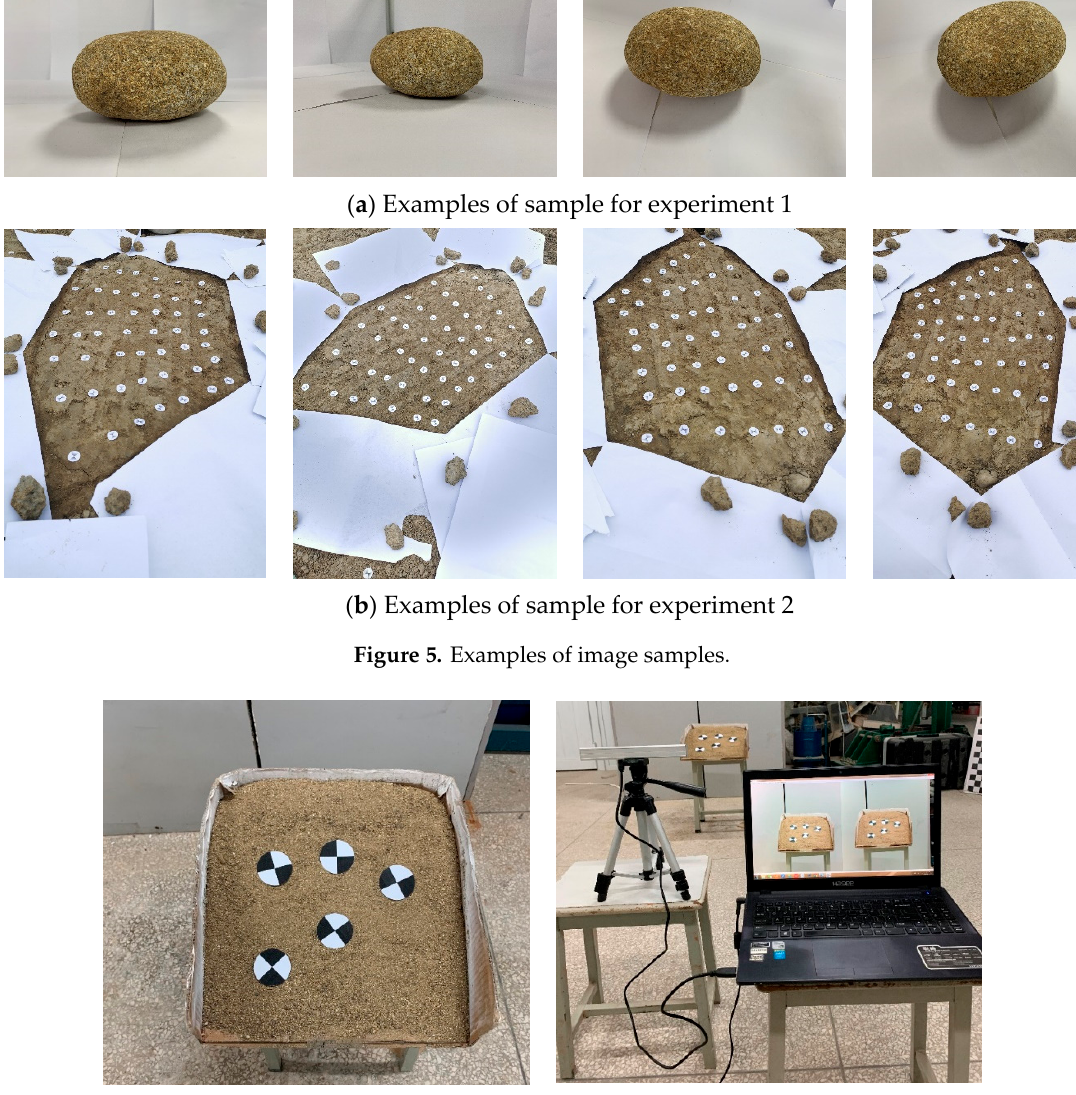
Figure 6. The slope model built in a laboratory environment.